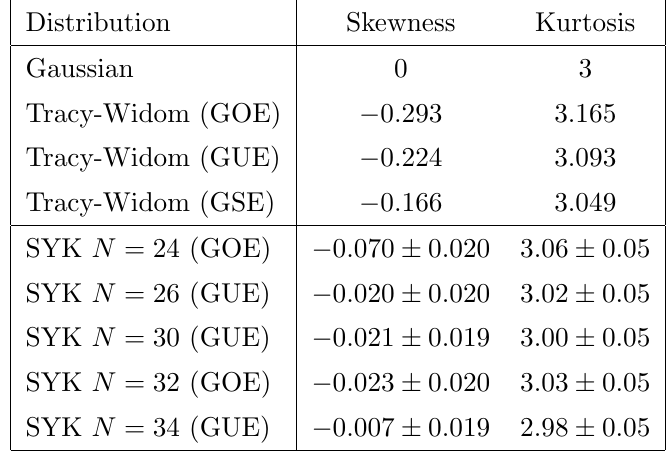
Table 1. Higher moments for the ground state energy distribution. SYK data was collected from 10 4 realizations for each value of N . GSE data is not shown because the ground state is in the odd charge sector, and we only computed the even charge sector.